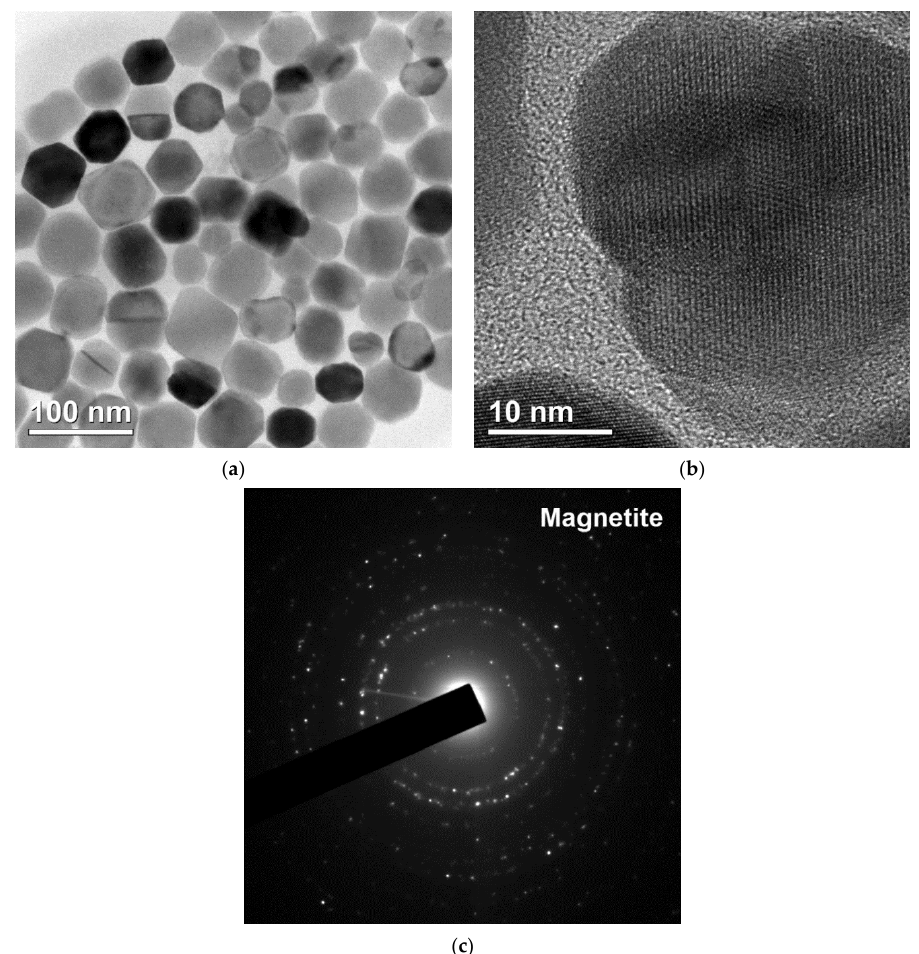
Figure 3. Transmission electron microscopy images of the isolated magnetosomes: ( a ) crystals of magnetosomes without membrane, ( b ) crystal lattice of an individual magnetite grain, ( c ) electron diffraction pattern.